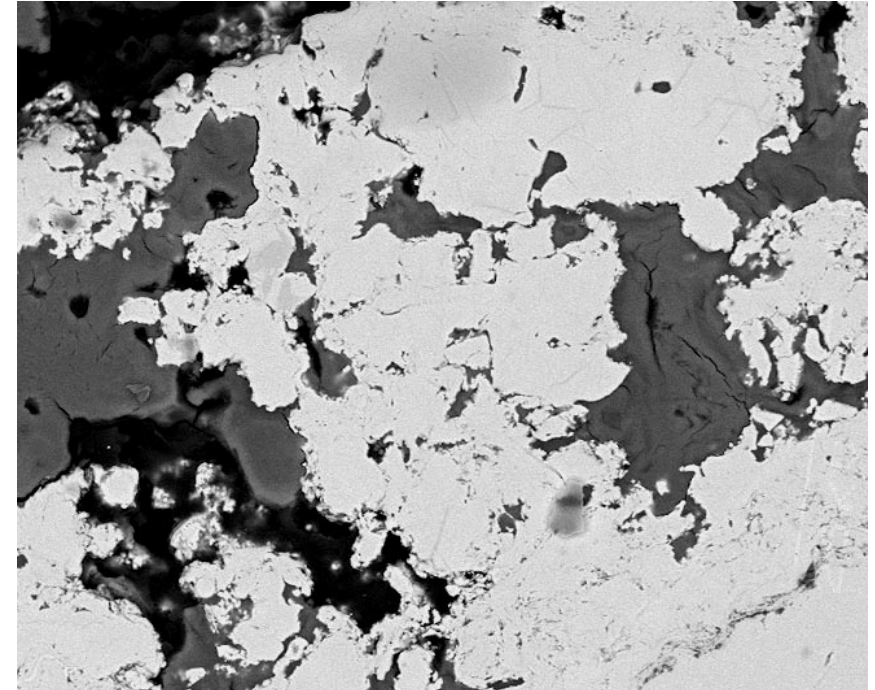
Figure 3. BSEM transverse section of a PS-coated titanium foam cylinder after 26 weeks of implantation into a rabbit femur (magnification